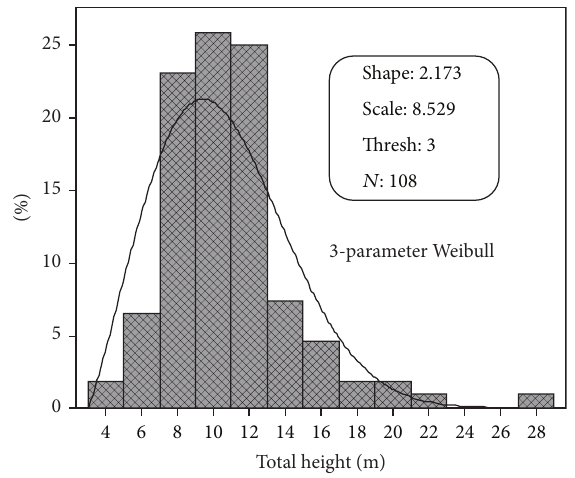
Figure 7: Height class-size distribution in the Sudanian